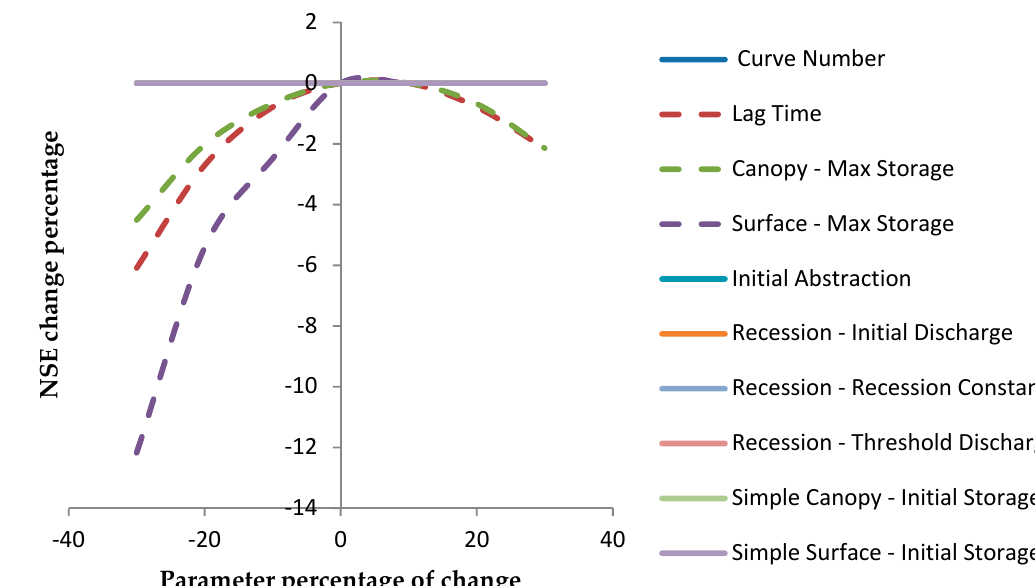
Figure 8. Model parameter sensitivity.